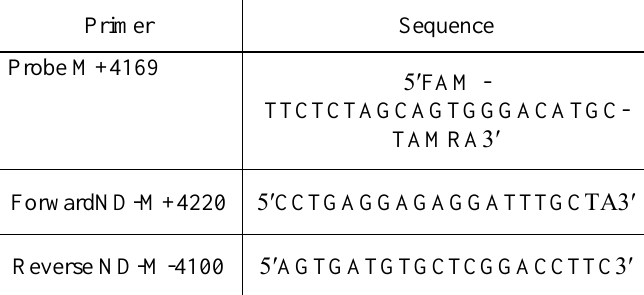
Table 1: The design of probe and primers used in Real-Time RT-PCR for the detection of NDV matrix protein